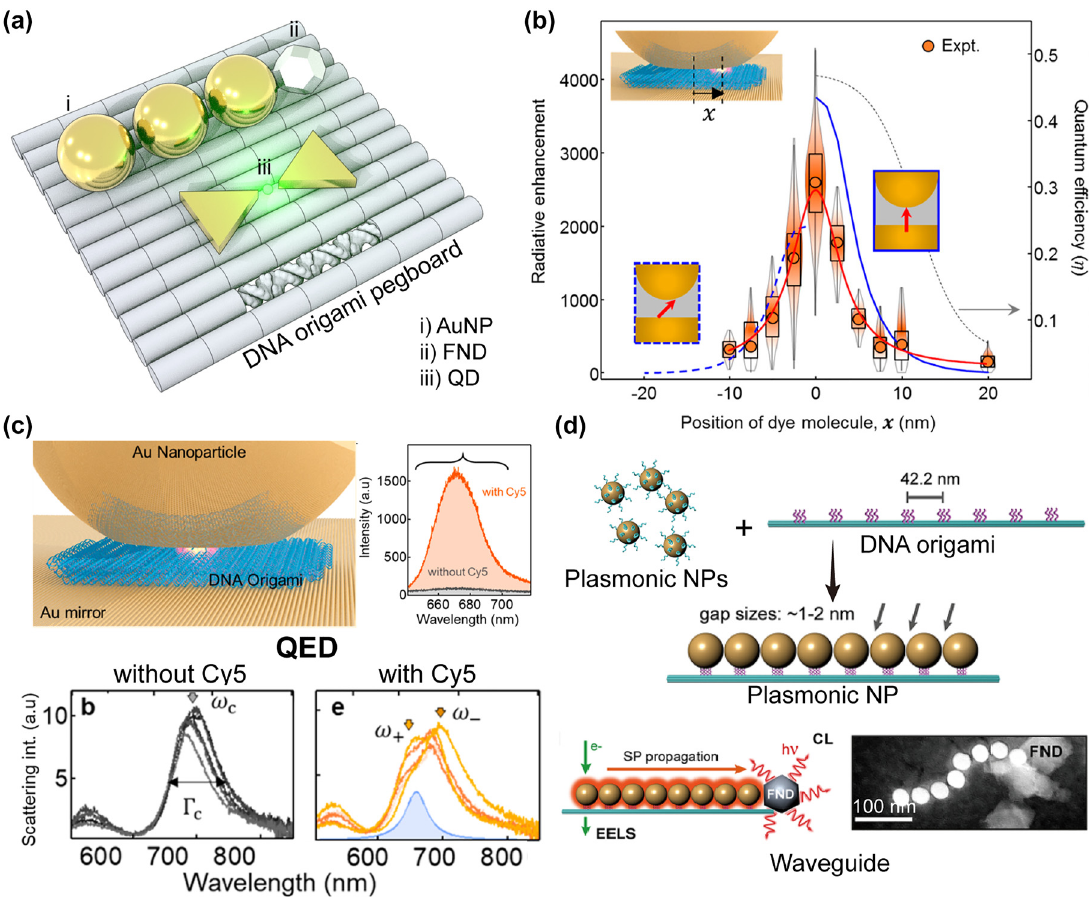
Figure 3: The usage of DNA origami in nanophotonics, (a) DNA origami as a molecular pegboard. Various MQEs including AuNP, FND, and QDs are placed on DNA origami through complementary binding. (b) Molecular quantum efficiency variation with respect to molecular positioning within NPoM cavity system. The dye location varies via DNA origami positioning. (c) Plasmonic cavity system via NPoM with single molecule within DNA origami [23]. The dye within hot spot strongly interact with cavity system results strong coupling (i.e., Rabi splitting). (d) Plasmonic waveguide mediated by DNA origami helix bundles [85]. Through surface plasmon (SP) propagation, the energy is transferred to FND with emission signal on the other side. Bottom panel shows experimentally realization of plasmonic waveguide. Parts (b) and (c) adapted with permission from Ref. [23]. Part (d) adapted with permission from Ref.